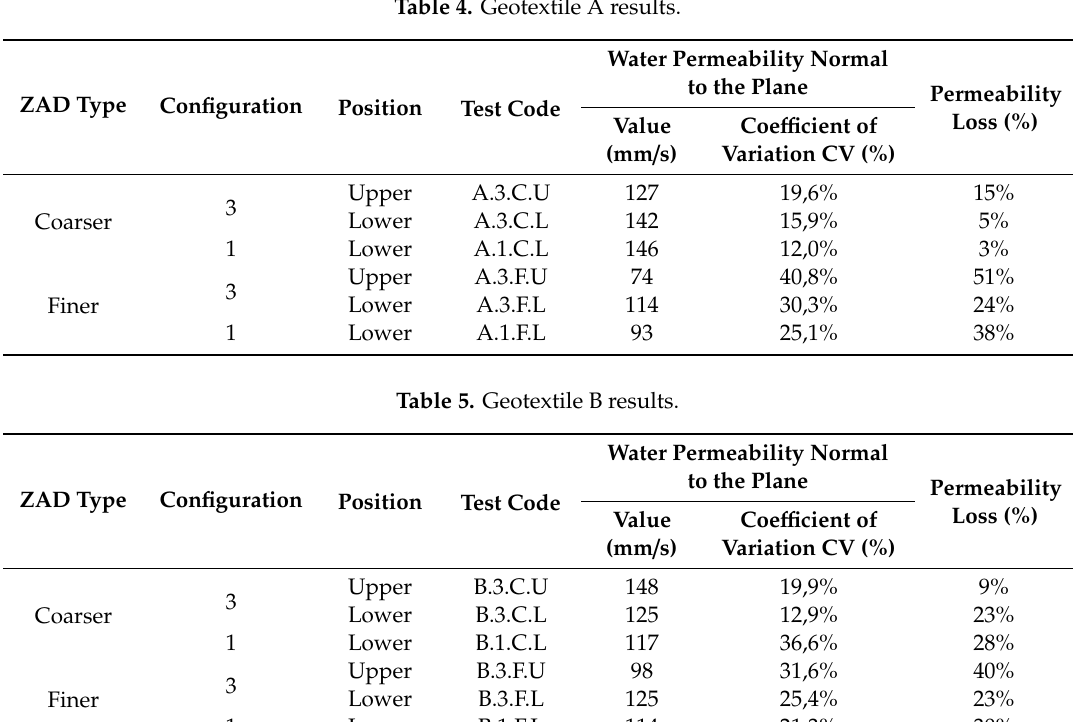
Table 4. Geotextile A results.